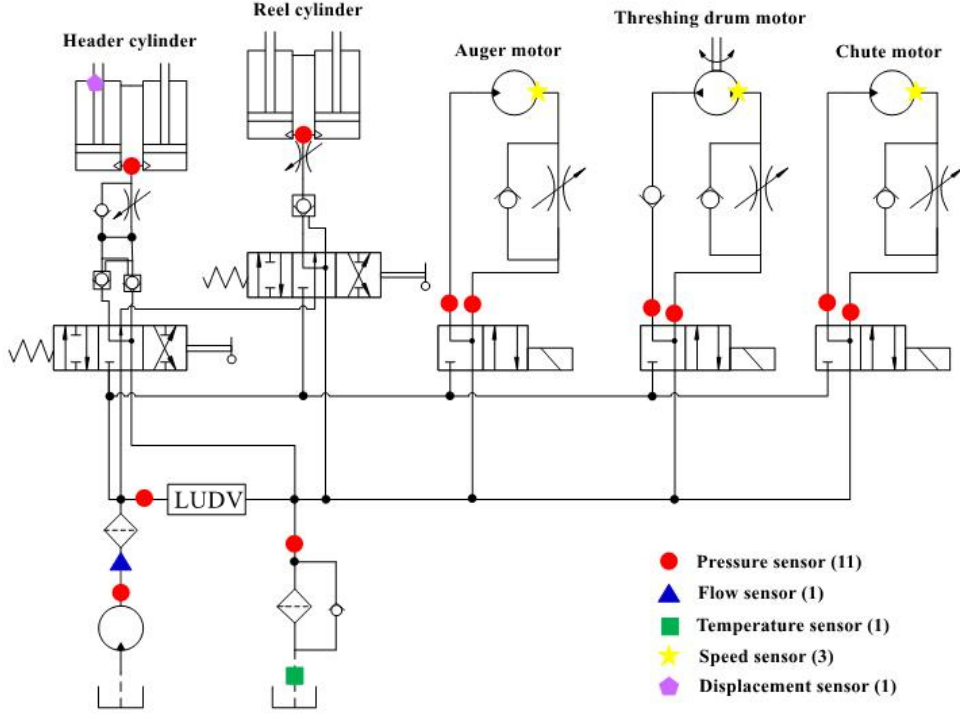
Figure 5. Hydraulic system monitoring point bitmap .